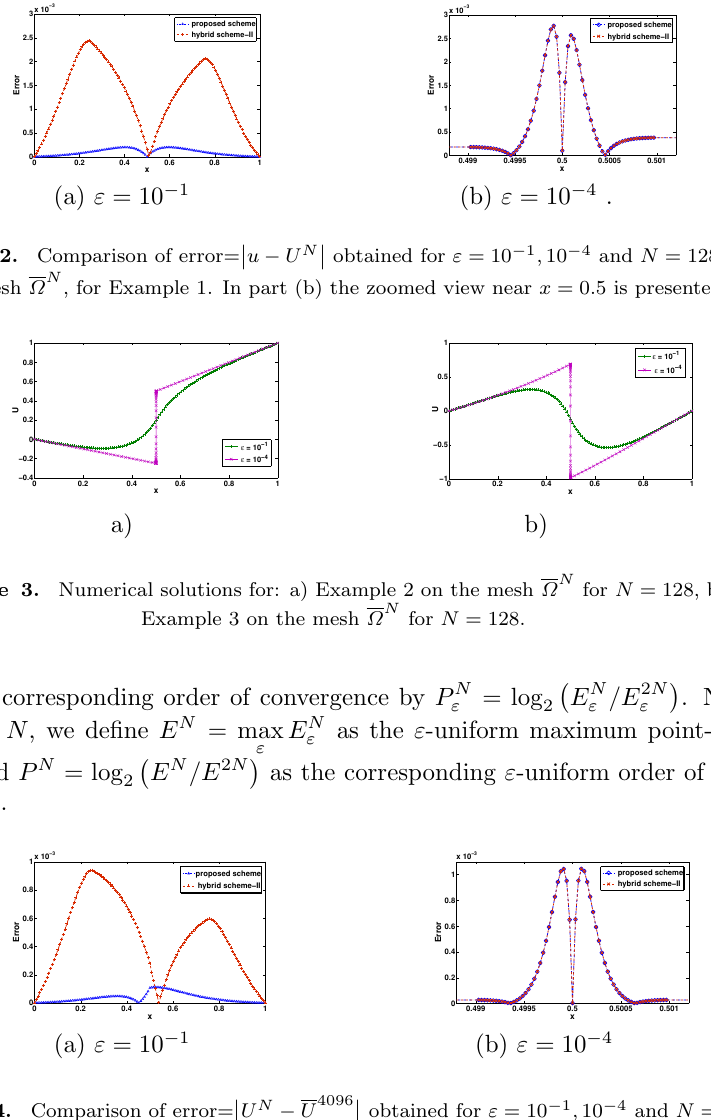
Figure 4. Comparison of error= (cid:12) (cid:12) U N − U 4096 (cid:12) (cid:12) obtained for ε = 10 − 1 , 10 − 4 and N = 128 on the mesh Ω N , for Example 2. In part (b) the zoomed view near x = 0 . 5 is